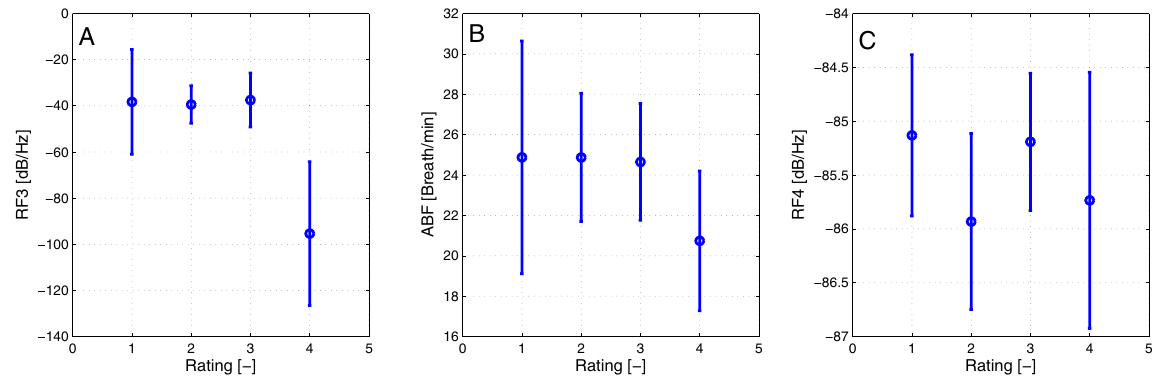
Figure 2. Mean and standard deviation of RF3, ABF, and RF4 parameters with respect to rating (1–most perceived stress, 4–least perceived